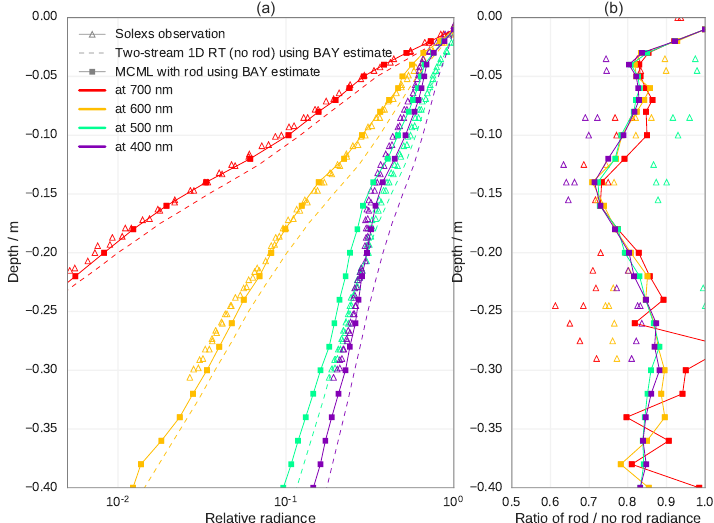
Figure 15. Same as Fig. 14 except that the simulations at 400 and 500nm use the BAY estimate of the ice absorption